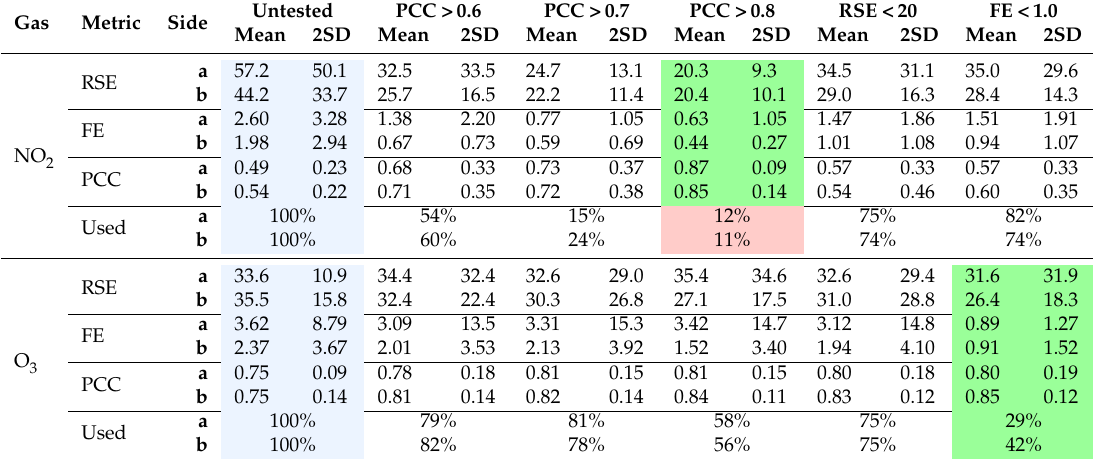
Table 2. Table of means and 95% confidence intervals for all goodness tests across the entire span of data, including data compiled without tests for reference. Rows discussed in the text are highlighted. For correlation, a higher mean score is better. For fractional error and residual standard error, a lower mean is better. Low 95% confidence intervals (2SD) are better all round.